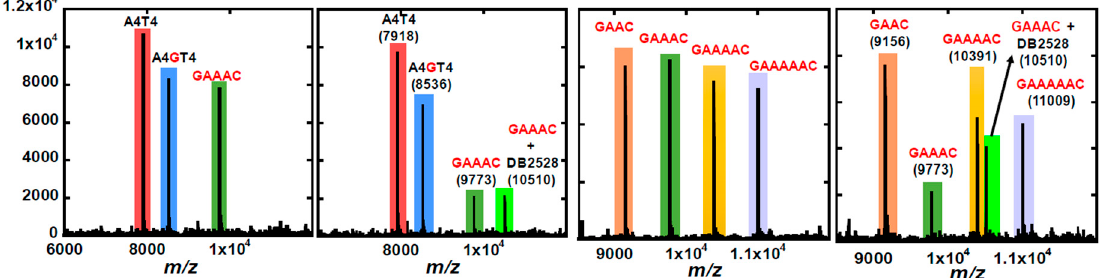
Figure 10. ESI-MS negative mode spectra of the competition binding of sequences (10 μ M each) with 40 μ M DB2528 in buffer (50 mm ammonium acetate with 10% methanol ( v / v ), pH 6.8). The ESI-MS results shown here are deconvoluted spectra and molecular weights are shown with each peak.